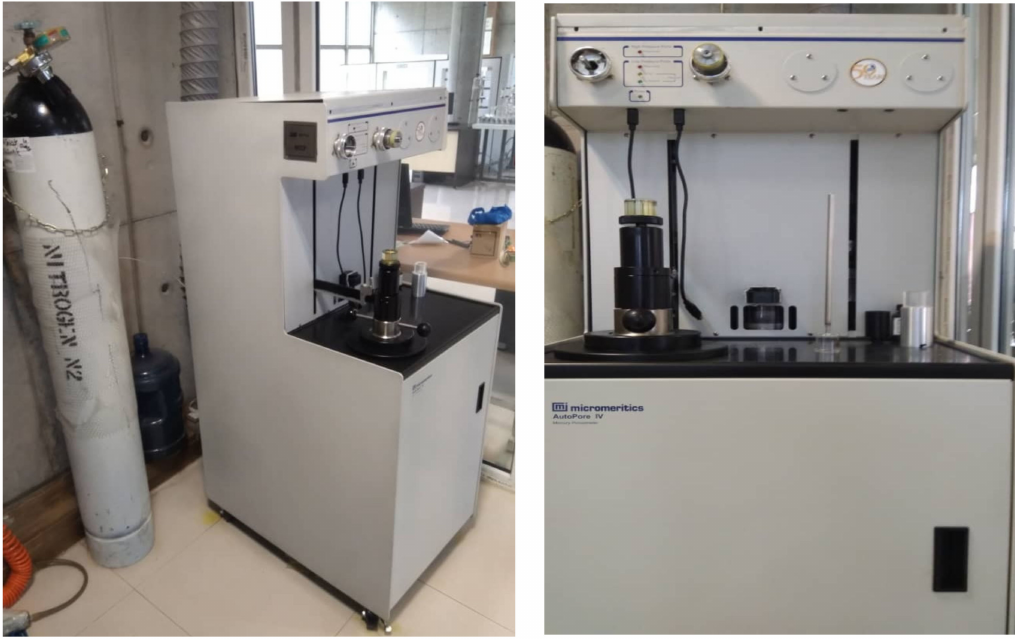
Figure 7. Setup used for mercury injection capillary pressure (MICP)